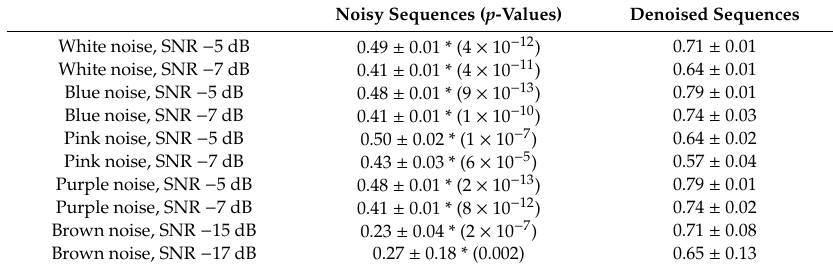
Table 4. Cross-correlation results with respect to clean (reference) sequences represented as mean ± sd, and the p